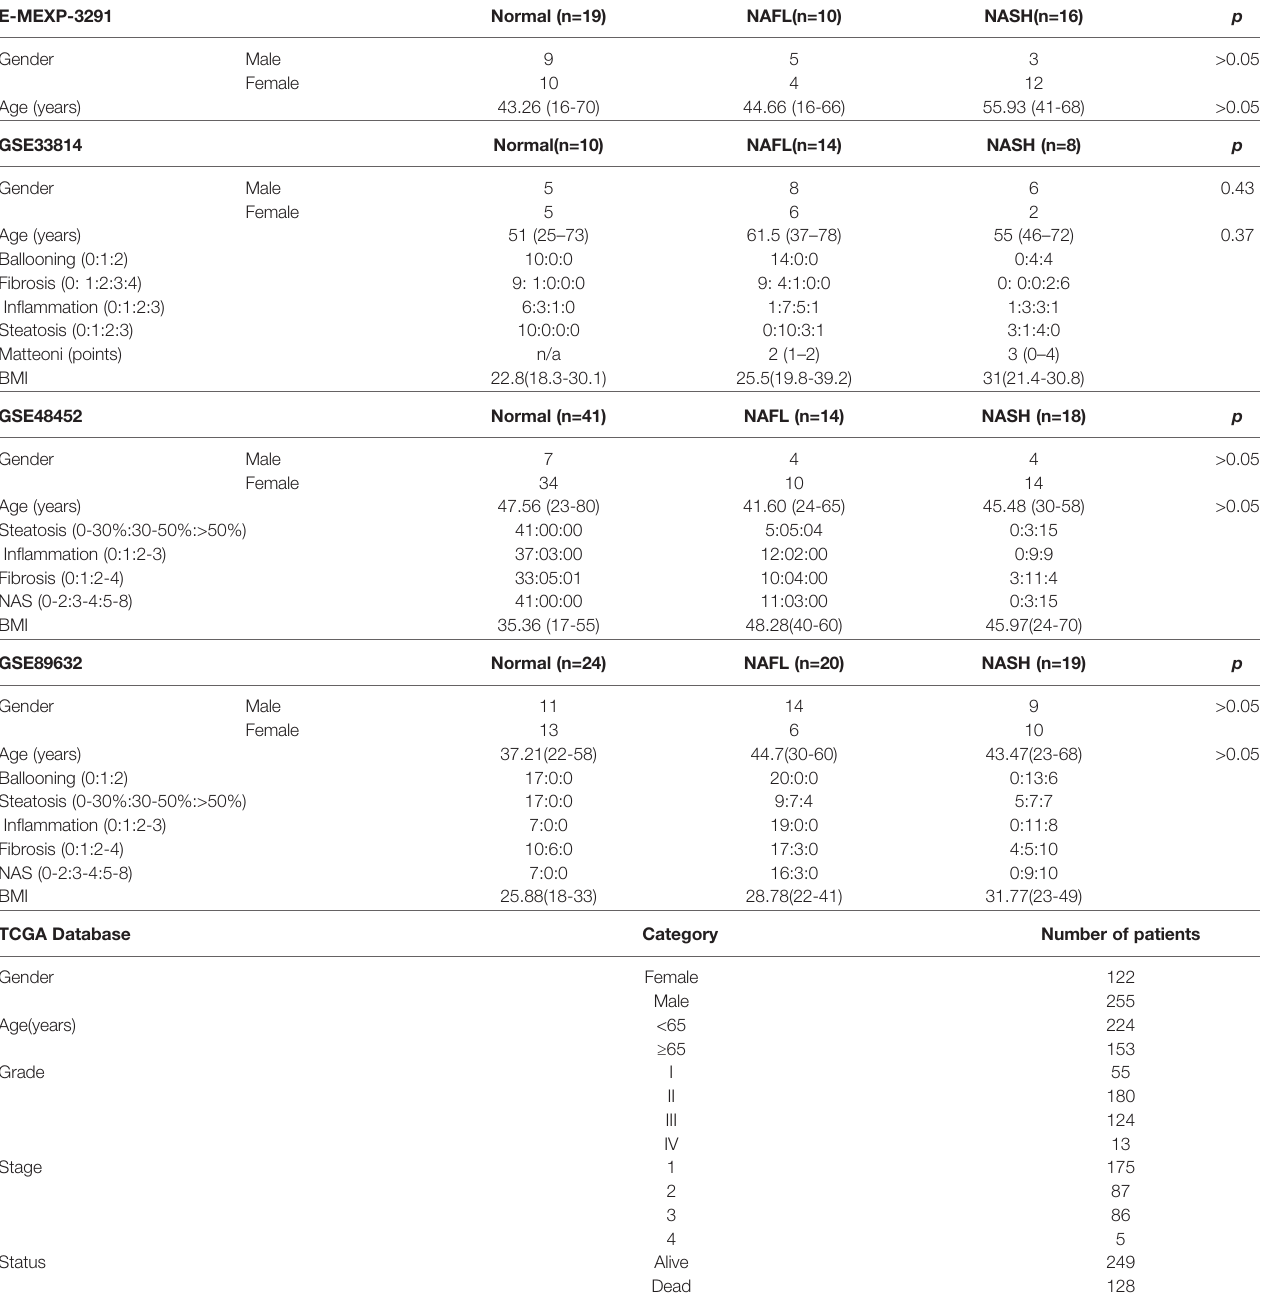
TABLE 1 | Clinical Characteristics of E-MEXP-3291, GSE33814, GSE48452, GSE89632 and TCGA-HCC.